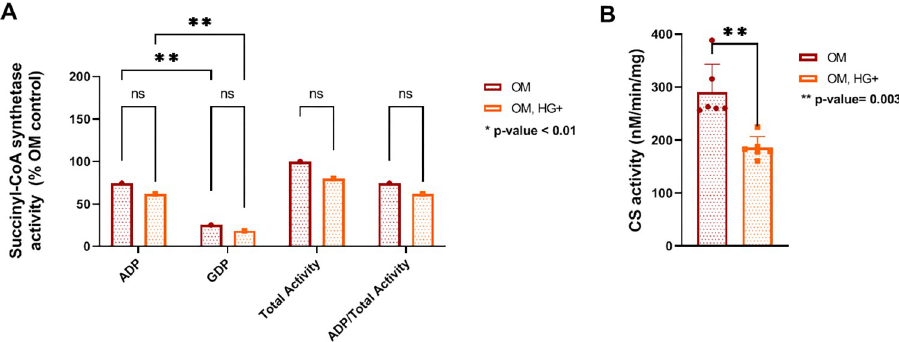
Fig 3. Key enzymes of the TCA cycle have reduced activity in HG-treated bone cells. A. Succinyl-CoA synthetase activity was calculated by measuring each substrate (ADP or GDP) and was expressed as percent total activity for each condition independently. Rates for Succinyl- CoA synthetase activity were calculated by measuring each substrate (ADP and GDP) and correcting for absence of either ADP or GDP. After correction, ADP and GDP activities of both OM and OM, HG+ cells as percent of total activity in OM cells. B. Citrate synthase activity of differentiated cells was calculated in the absence and presence of HG. CS activity data represent two independent experiments. All experiments were performed in triplicates. CS activity was analyzed by Student T-test paired-wise comparison. SCS activity was analyzed by Two-way ANOVA. CS activity data correspond to two technical replicates of N = 6 independent experiments in